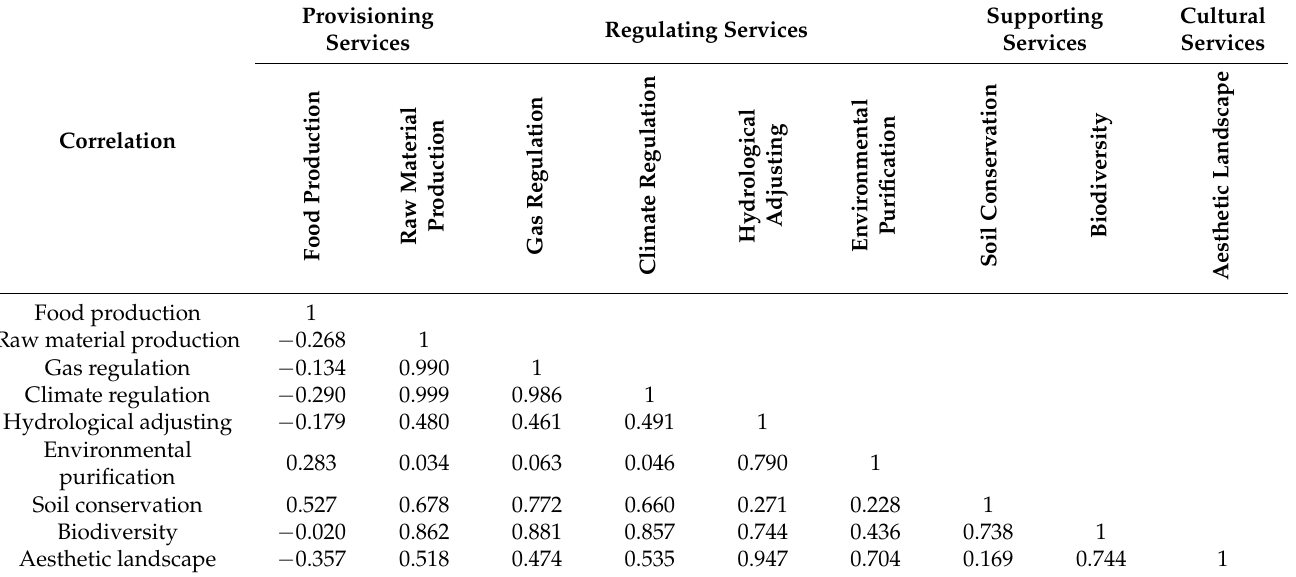
Table 5. Correlation of ecosystem services in Sichuan